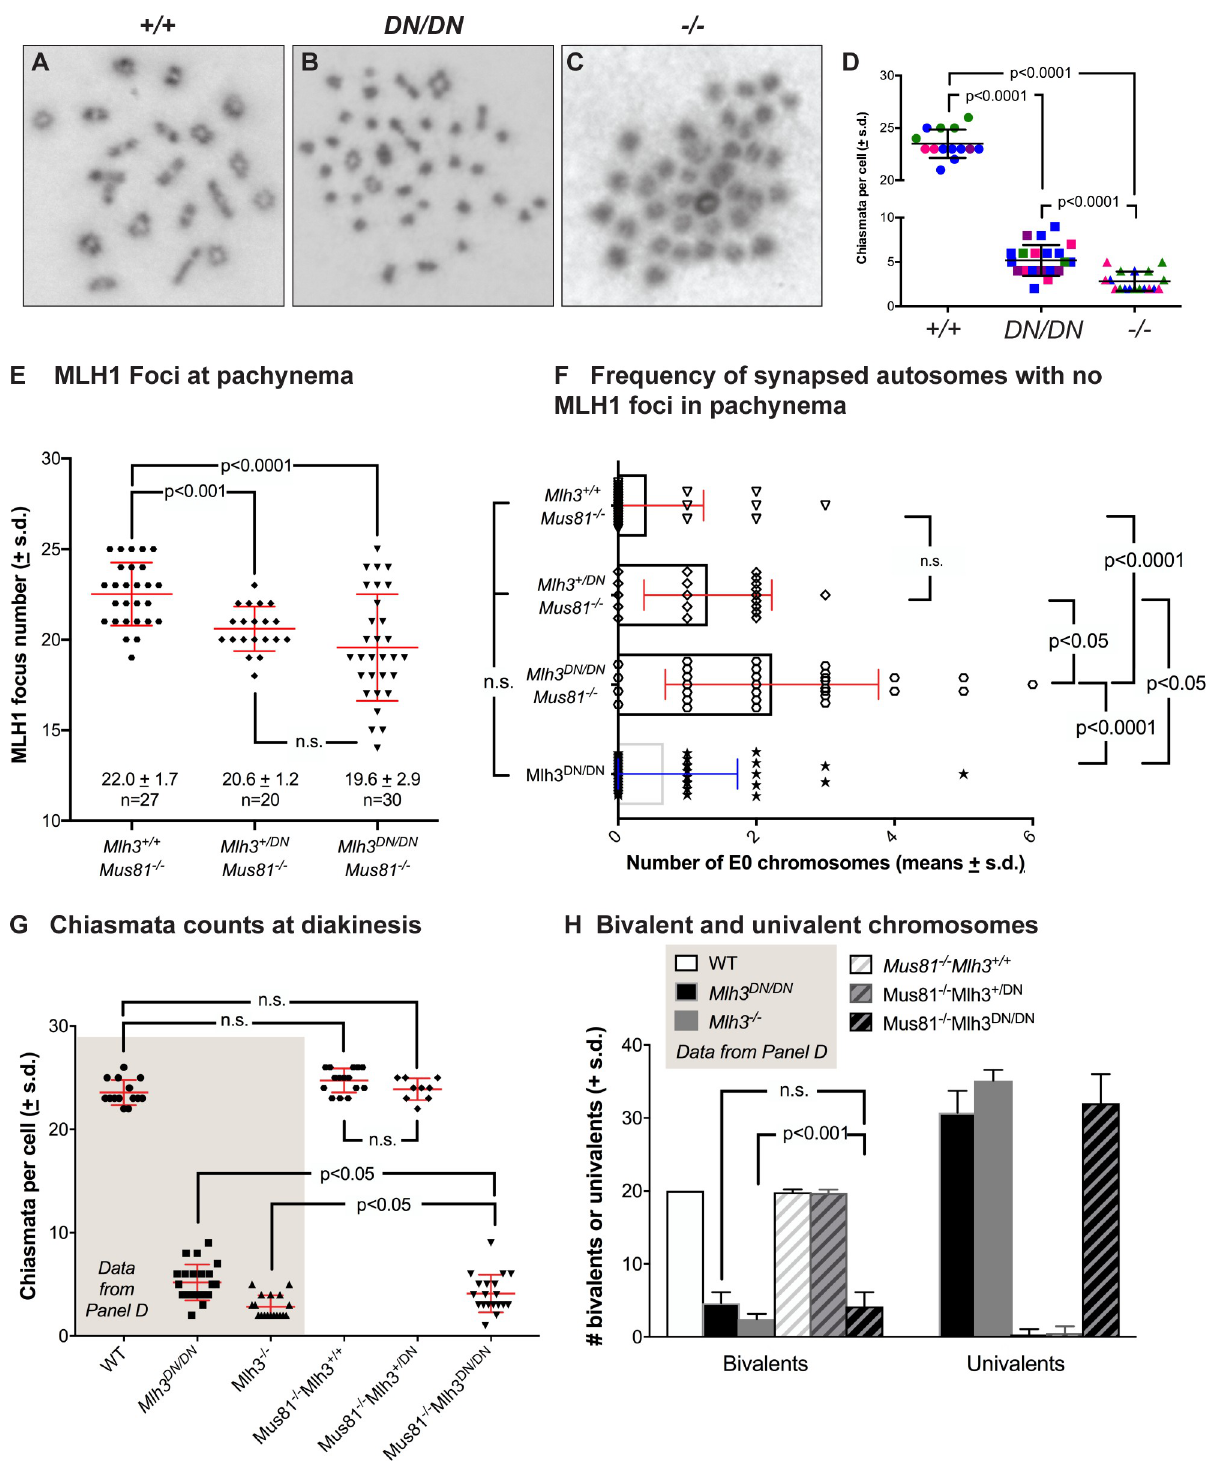
Fig 6. Mlh3 DN/DN diakinesis staged spermatocytes show a reduced number of chiasmata (A-D) , while comparison of MLH1 focus frequency (E) and distribution (F) during pachynema, and chiasmata counts (G) and bivalent/univalent frequencies (H) in Mus81 -/- Mlh3 +/+ , Mus81 -/- Mlh3 +/DN , and Mus81 -/- Mlh3 DN/DN males indicates partial involvement of class II CO pathway. (A-C) Diakinesis staged spermatocyte preparations from WT, Mlh3 DN/DN , and Mlh3 -/- males stained with Giemsa showing chiasmata formation between homologous chromosomes. Note that diakinesis spread chromosomes are not provided with scale bars because the degree of “spread” varies from cell to cell, thus it is hard to compare true magnifications